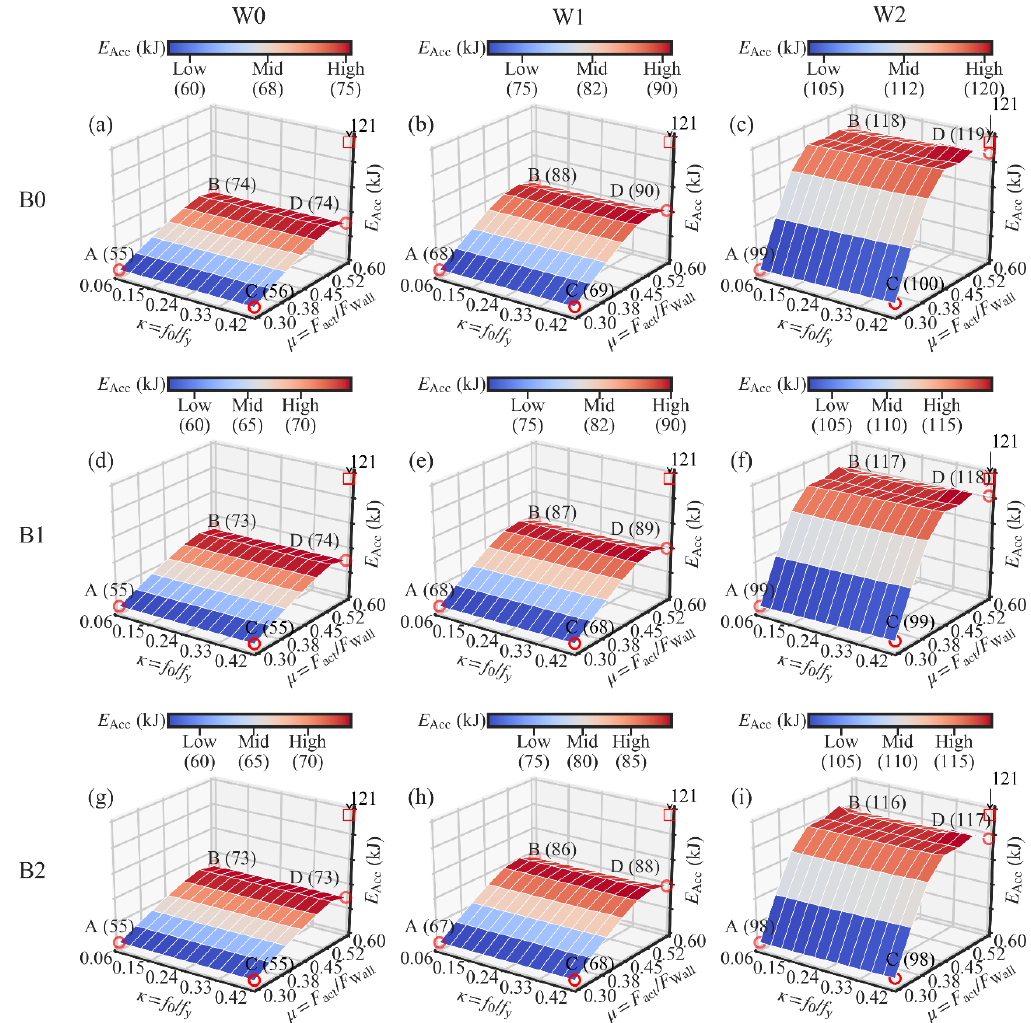
Figure 15. Three-dimensional surfaces of the energy dissipation: ( a ) W0B0; ( b ) W1B0; ( c ) W2B0; ( d ) W0B1; ( e ) W1B1; ( f ) W2B1; ( g ) W0B2; ( h ) W1B2; ( i ) W2B2.